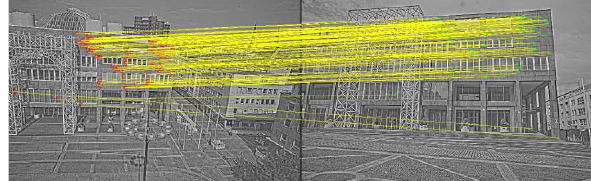
Figure 11: pair-8 results: SIFT matching in Wallis-filtered